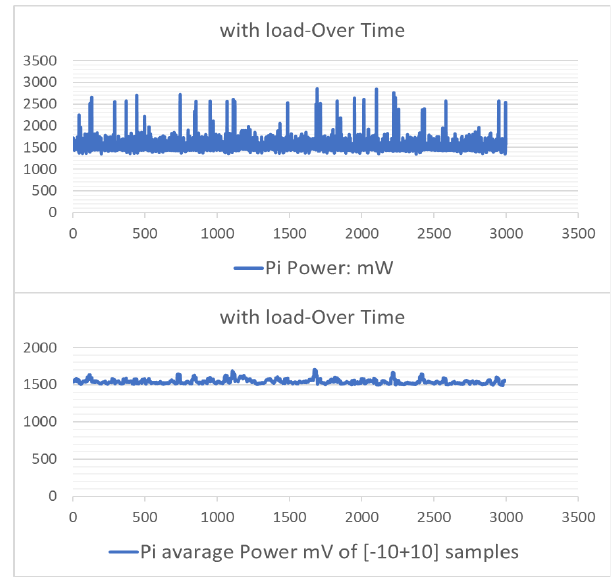
Figure 36. 1 h running Pi in load